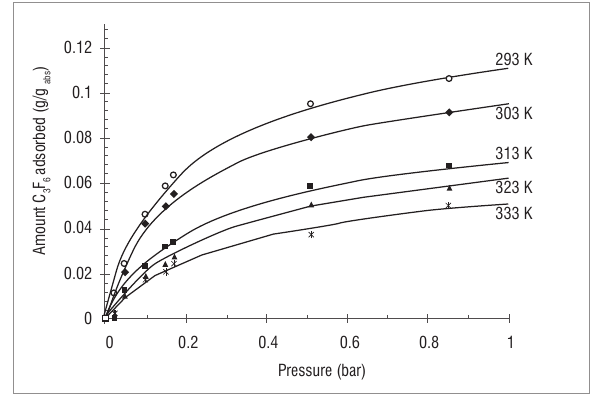
F on Teflon AF 2400 at different 3 6